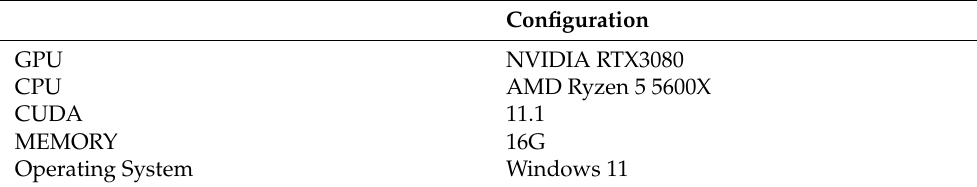
Table 2. Experimental environment